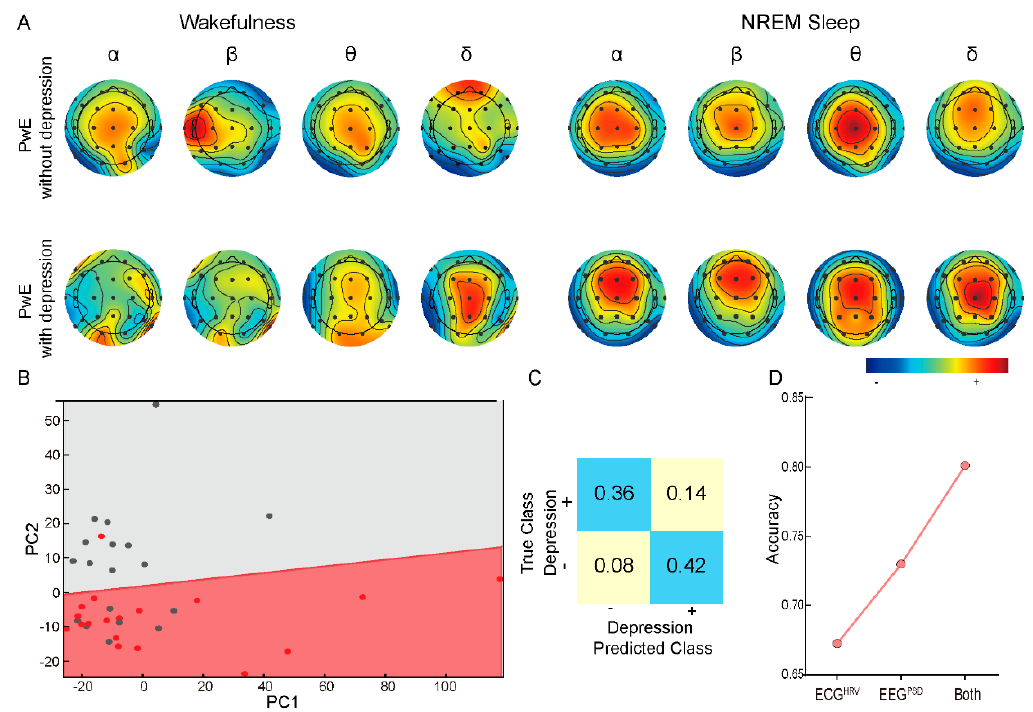
Figure 4. Combining HRV and EEG power spectral density (PSD) data further improves depression classification. ( A ) Topographical representation of four frequency band ( α (8 − 13 Hz), β (14 − 30 Hz), θ (4 − 7.5 Hz), δ (0.3 − 3.5 Hz)) in PwE with/without depression. ( B ) Principal component analysis (PCA) has been performed through selected HRV parameters and EEG PSD values, showing a better classification than HRV parameters only. ( C ) Confusion matrix analysis through selected HRV and EEG PSD data showed lower false positives/negatives and higher true positives/negatives than HRV parameters only. ( D ) Comparison of classification accuracy in HRV and EEG PSD data, the highest accuracy was achieved while combining HRV and EEG PSD data in the algorithm. The red and gray dots representing PwE with and without depression in Figure 4B, respectively. PwE − people with epilepsy.